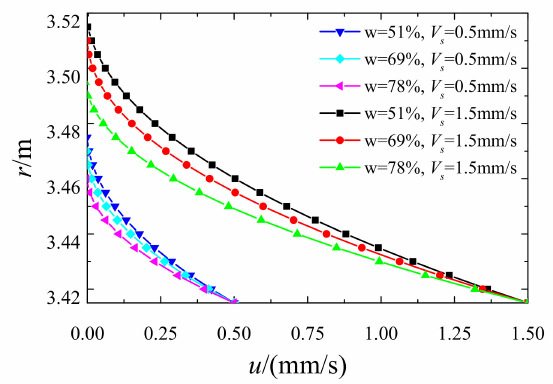
Figure 5. Soil flow velocity distribution